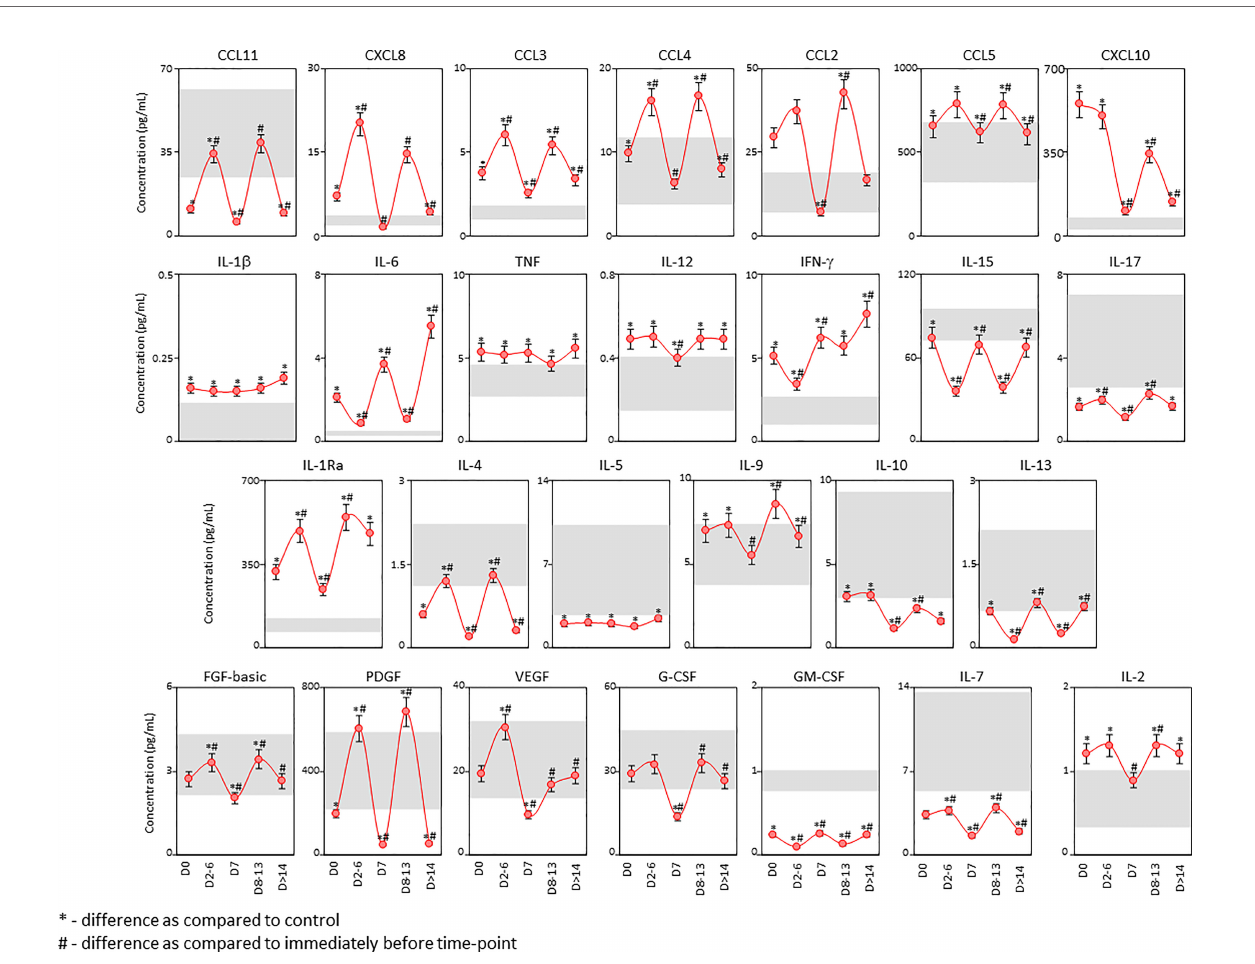
FIGURE 4 | Kinetic timeline of soluble immune mediators in serum samples from critically ill COVID-19 patients. The kinetic pro fi le of chemokines (CXCL8, CCL11, CCL3, CCL4, CCL2, CCL5, CXCL10), pro-in fl ammatory cytokines (IL-1 b , IL-6, TNF, IL-12, IFN- g , IL-15, IL-17), regulatory cytokines (IL-1Ra, IL-4, IL-5, IL-9, IL-10, IL- 13) and growth factors (FGF-basic, PDGF, VEGF, G-CSF, GM-CSF, IL-7 and IL-2) was evaluated in serum samples from critically ill COVID-19 patients ( ● , n = 183) by cross-sectional analysis at four consecutive time points (Days = D), including: D0 (n = 183), D2-6 (n = 99), D7 (n = 80), D8-13 (n = 50) and D>14-36 (n = 65) after ICU admission. Measurements were carried out by high-throughput microbeads array as described in Material and Methods section. The results are presented as a line chart of median values (± 10% of median) at each time point along the kinetic timeline. The gray zone represents the reference interquartile range (25 th -75 th ) observed for pre-pandemic healthy controls “ HC ” (n = 135). Signi fi cant differences at p < 0.05 are identi fi ed by asterisks (*) as compared with “ HC ” and by hashtag (#) for immediately preceding